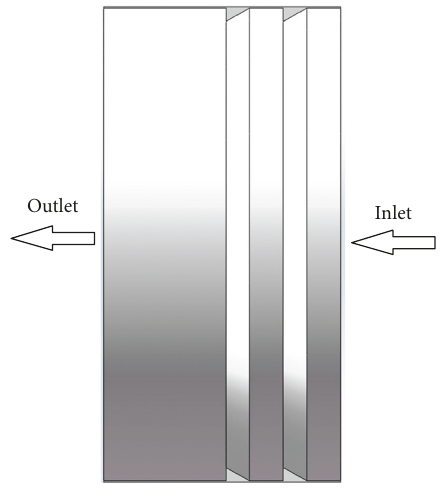
Figure 11: Fluid